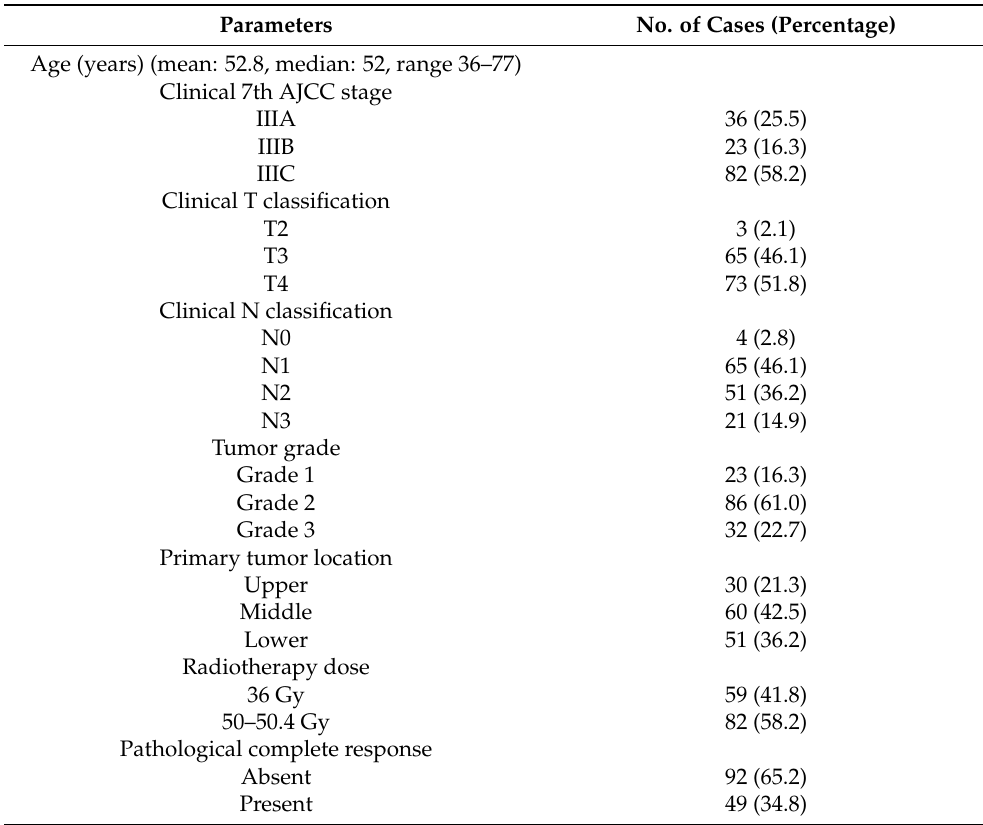
Table 1. Clinicopathologic features of 141 patients with 7th AJCC stage III esophageal squamous cell carcinoma receiving preoperative chemoradiotherapy.